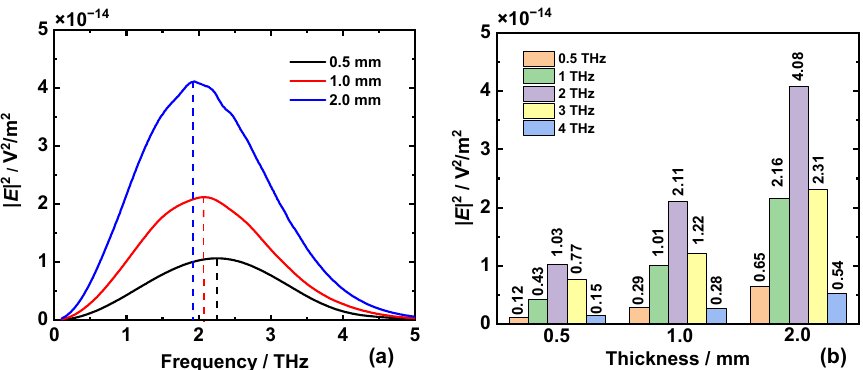
Figure 5. Terahertz intensity generated by RQPM OR in polycrystalline ZnSe samples with different thickness: ( a ) terahertz spectrum; ( b ) nonlinear terahertz signal growth at certain frequencies. The grain size distribution ( μ , σ ) was (82, 35) in micron.